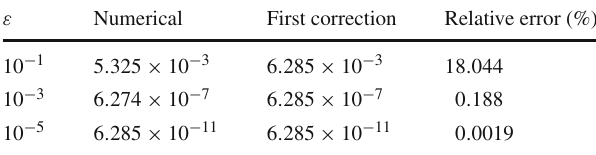
second column shows the numerical result calculated from (26), the third column shows the first order correction given by (28) and the last column shows the relative error between the two